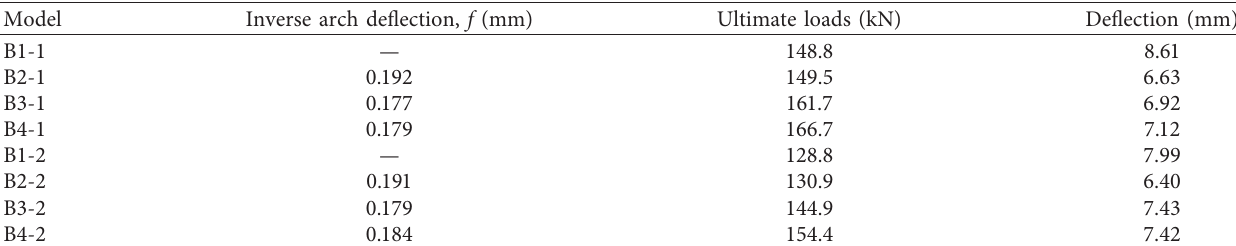
Table 7: Simulation results of the model.